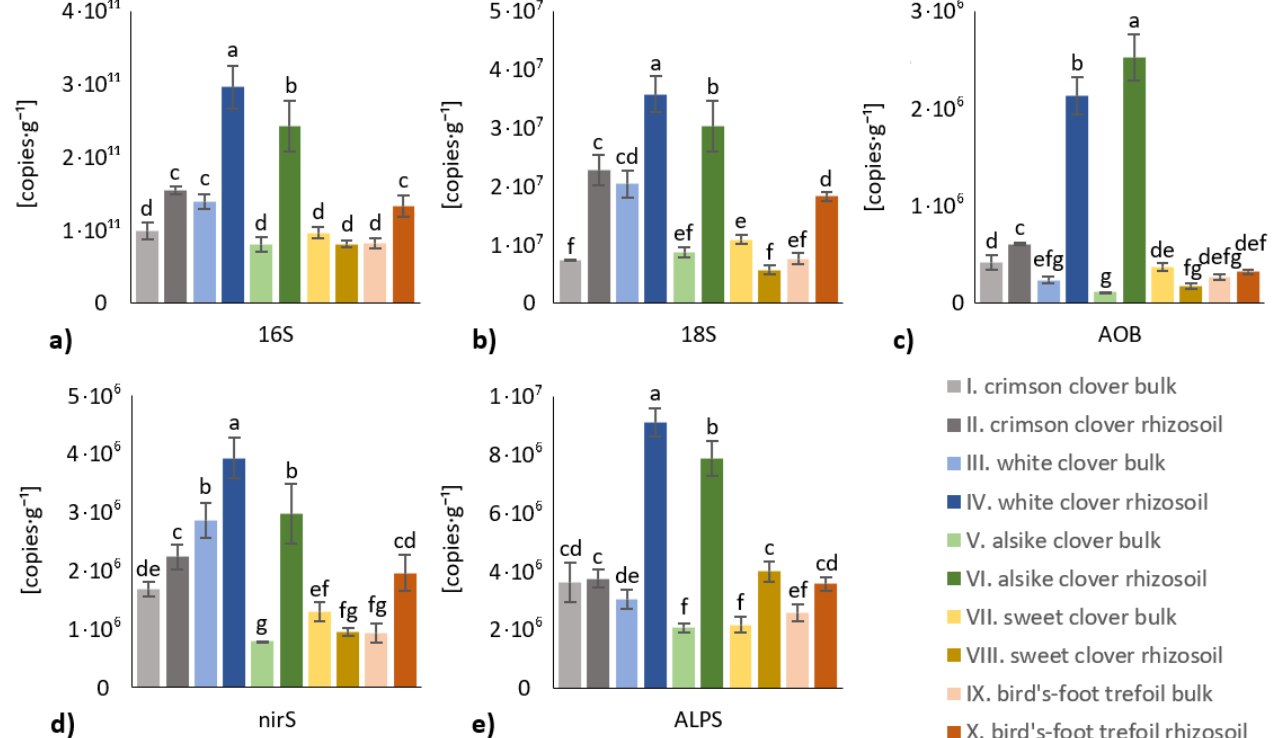
Figure 5. Microbial biomass (determined as copy number of target genes specific to functional groups) in rhizosoil and bulk soil of experimental variants, collected from field cultures of various types of clover/legume crops after plant growth period 76 days: ( a ) bacterial biomass (16S), ( b ) fungal biomass (18S), ( c ) biomass of ammonium oxidizing bacteria (AOB), ( d ) biomass of denitrifying bacteria (nirS) ( e ) biomass of phosphorus solubilizing bacteria (ALPS). Values (displayed in copies ⋅ g − 1 ) were calculated as average from independent replicates (n = 24), error bars represent standard deviation. The different letters express the statistical differences at significance level p ≤ 0.05.